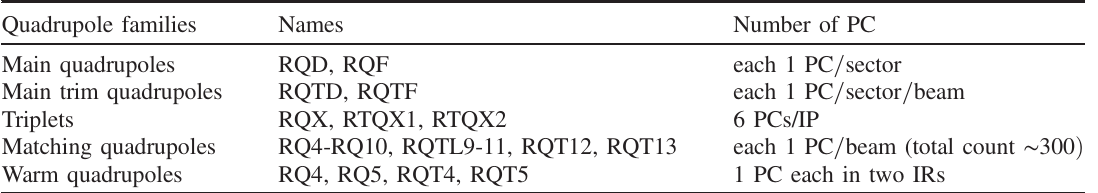
TABLE I. Quadrupole families in the LHC and the number of responsible power-converters. Names follow the LHC naming